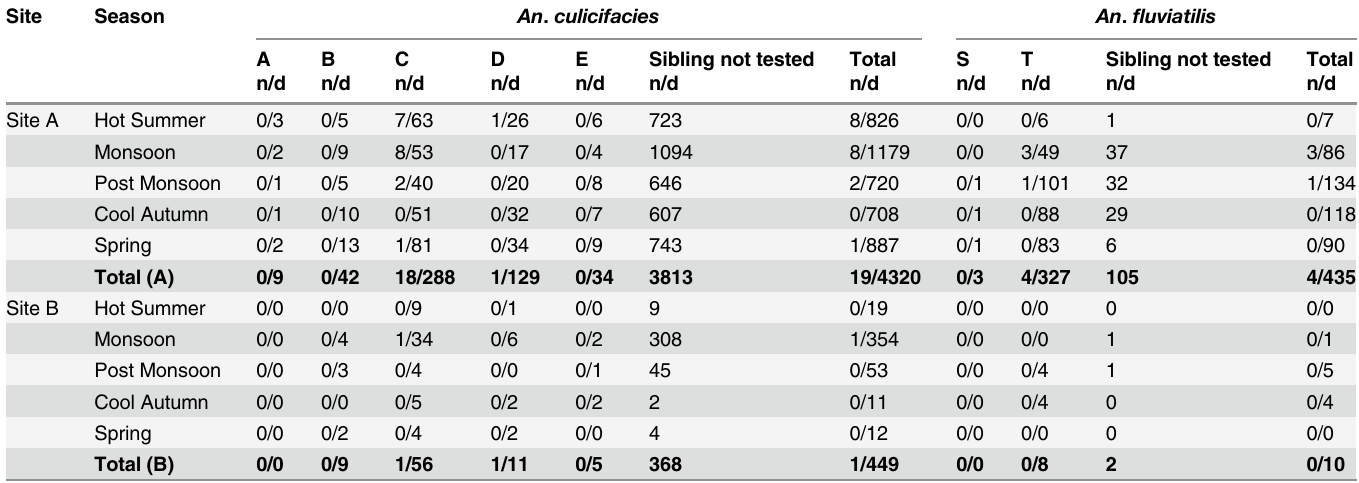
Table 4. Season wise distribution of sibling species and sporozoite positive of An . culicifacies , An . fluviatilis in Bargi and Sihora PHCs, Jabalpur, Madhya